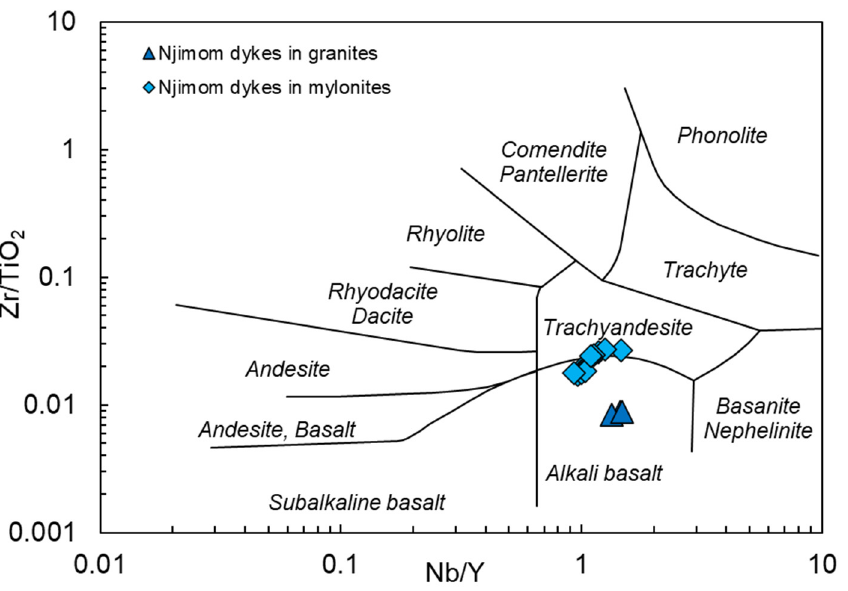
Figure 8. TAS classification diagram [18] for the Njimom dykes. The subalkaline-alkaline line is from [22]. Data of mafic dykes (Bangoua, Dschang, Maham, and Kendem) are from [7], Kekem dykes from [5], Manjo dykes from [6], Nyos dykes from [23].